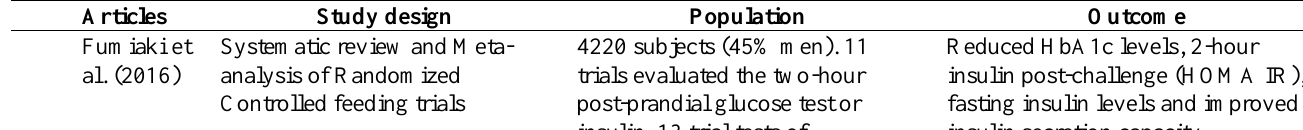
Table 2 The Characteristics of the Literature